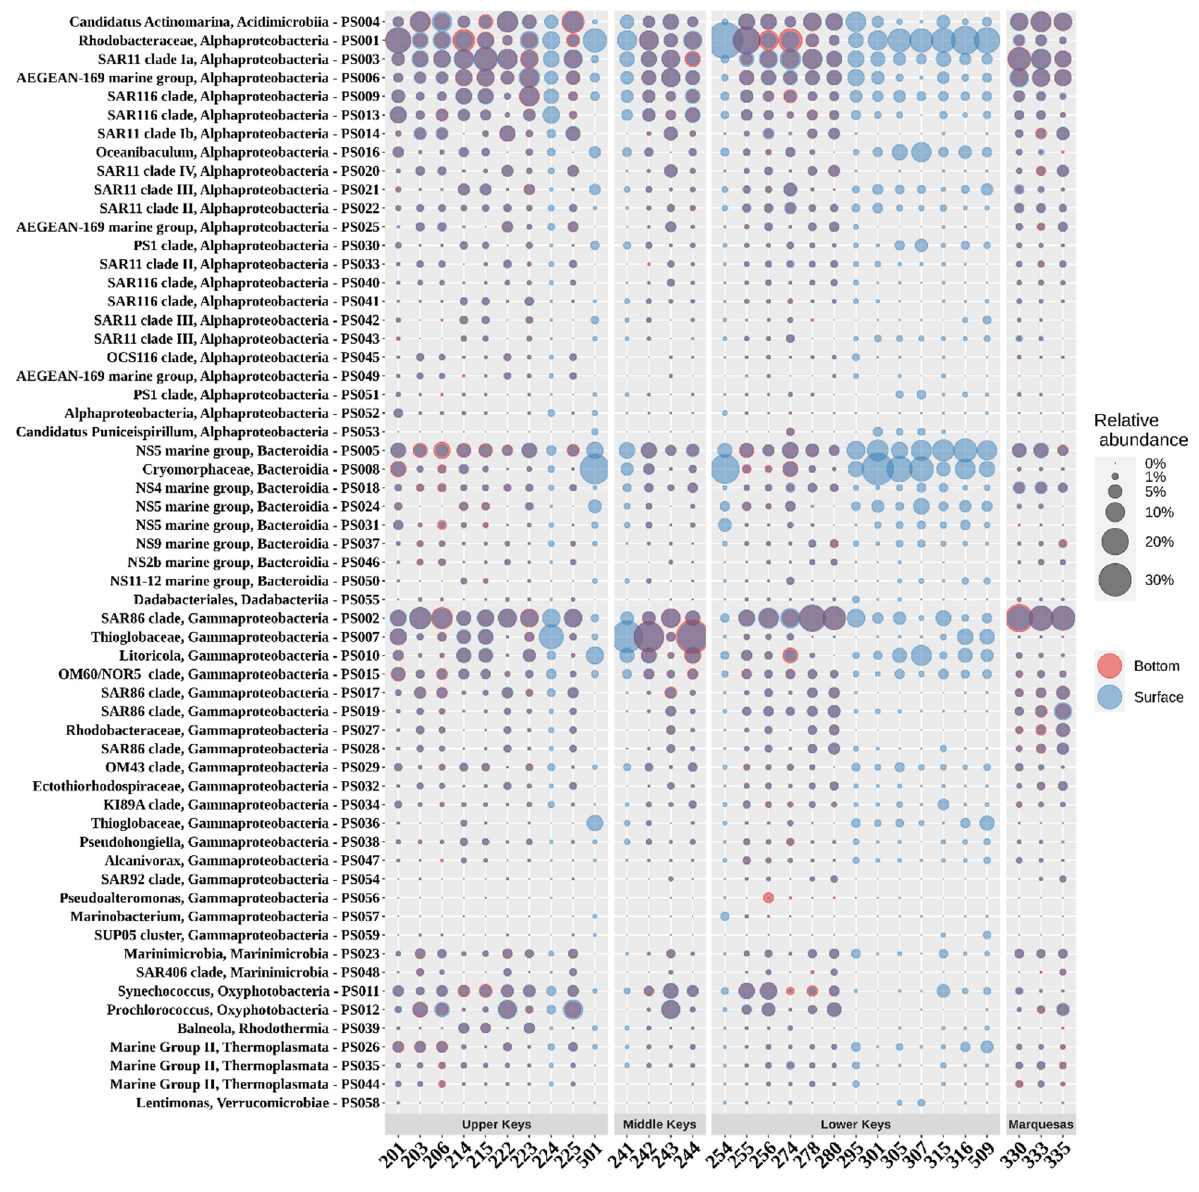
Figure 5. Relative abundance of the most abundant prokaryotic taxa at species level (accounted for at least 1% in one sample).